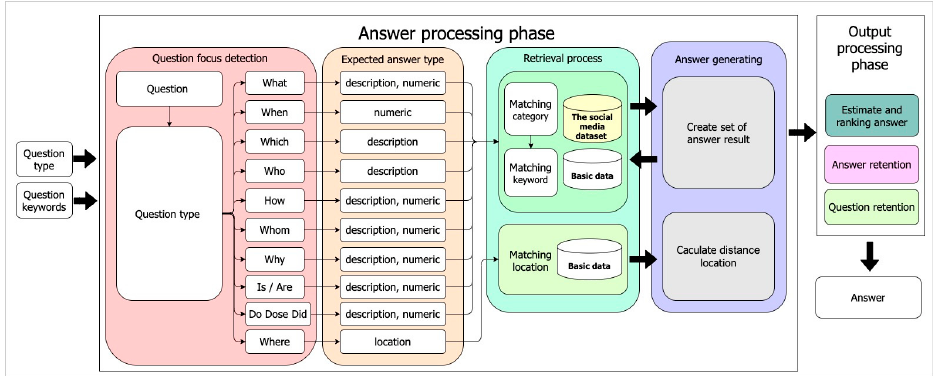
Figure 3. The system framework in part of answer processing and output processing.